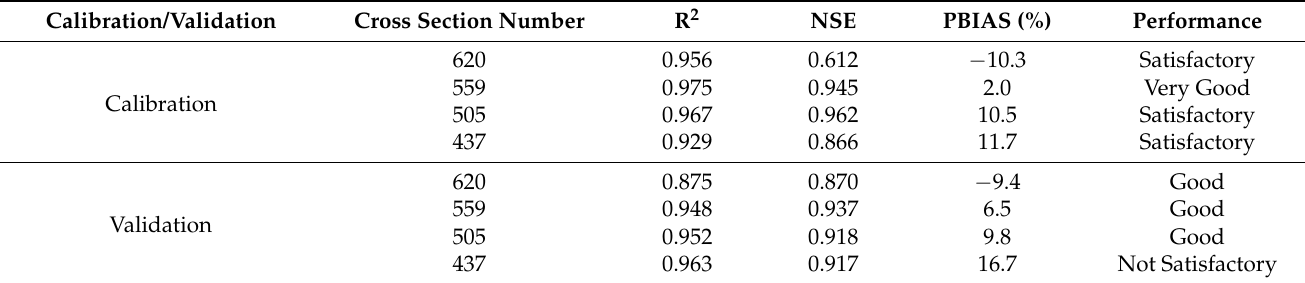
Table 7. Hydraulic model performance for unsteady flow.